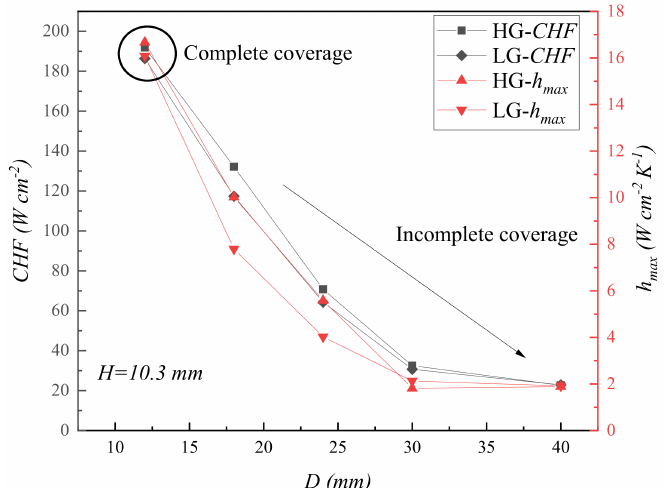
Figure 13. CHF and h max versus D at H = 10.3 mm.